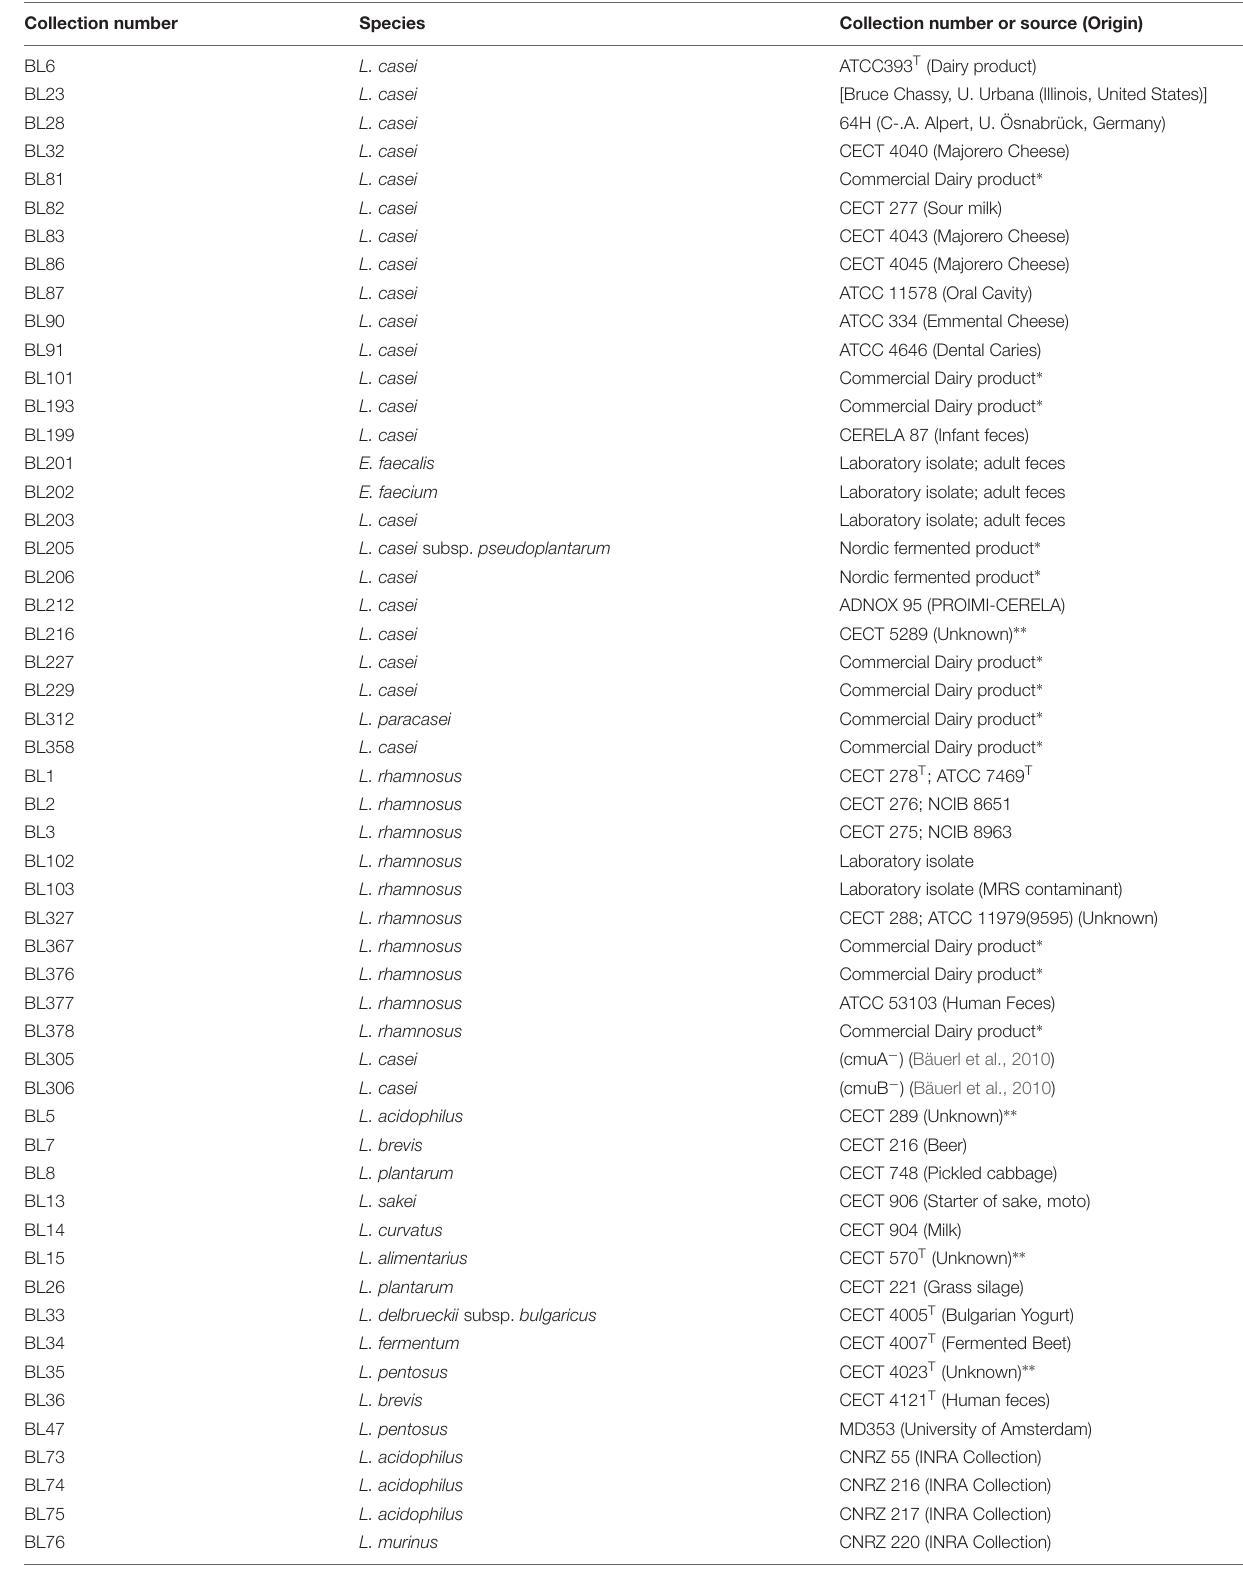
TABLE 1 | List of Lactobacillus strains used in this study. Collection